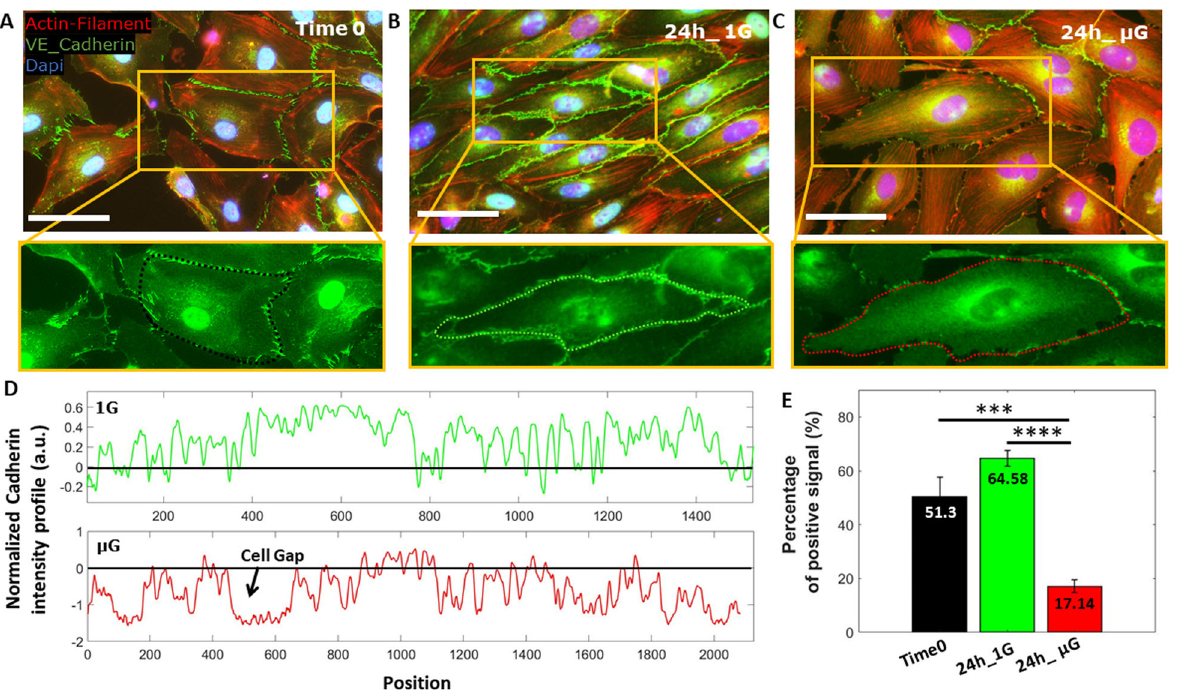
Fig. 6 Junction development evaluation. Fluorescence images of a sub-con fl uent monolayer of HUVECs showing Actin-Filament. (red), VE- Cadherin (green) and Dapi (blue) at Time 0 ( A ) and after 24 h of gravity (1 G) ( B ) and μ G ( C ) conditions. D Fluorescence. pro fi le of VE-Cad patter along the perimeter of the cell for 1 G and μ G sample. The positive intensity represents junctional protein formation while the negative intensity indicates gaps between cells. E Histogram showing the percentage of positively stained VE-Cad along the entire cell border for all experimental conditions. Scale bars, 50 µm. Data are shown as the mean ± SEM ( n = 50). Asterisks are reported for cases with statistical signi fi cance: **** 24 h 1 G Vs 24 h μ G, p = 0.0001. The statistical analysis of the data was performed using one-way analysis of variance (ANOVA) with Turkey ’ s test for multiple